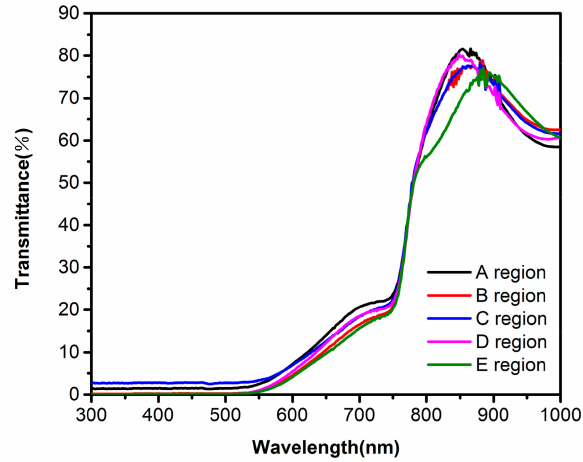
Figure 8. The transmission spectra of A, B, C, D and E regions of large-area perovskite MAPbI 3 thin films.